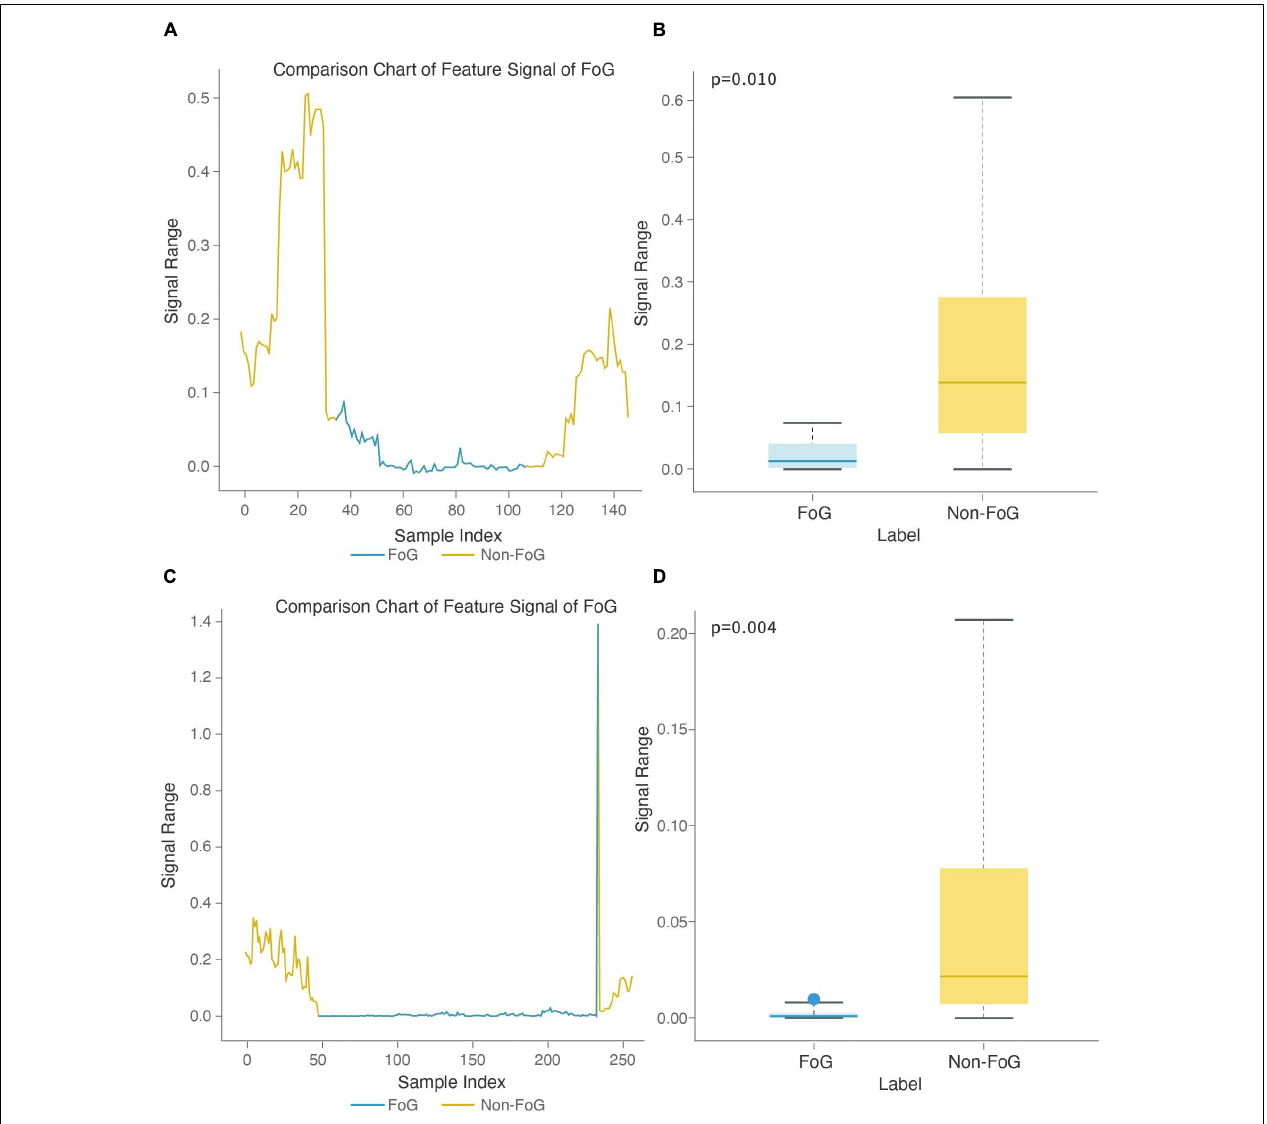
FIGURE 7 | Feature boxplot and stage comparison chart analysis in the walking stage. (A) Stage comparison chart of the area under the power spectrum of the 0.5-3 Hz frequency band calculated by the Y -axis acceleration signal from the right heel. (B) Boxplot of the area under the power spectrum of the 0.5-3 Hz frequency band calculated by the Y -axis acceleration signal from the right heel. The feature was significantly different between the FOG and non-FOG groups ( p = 0.010). (C) Stage comparison chart of the area under the power spectrum of the 1-1.5 Hz frequency band calculated by the Y -axis speed signal from the left heel. (D) Boxplot of the crest factor calculated by the area under the power spectrum of the 1-1.5 Hz frequency band calculated by the Y -axis speed signal from the left heel. The feature was significantly different between the FOG and non-FOG groups ( p =